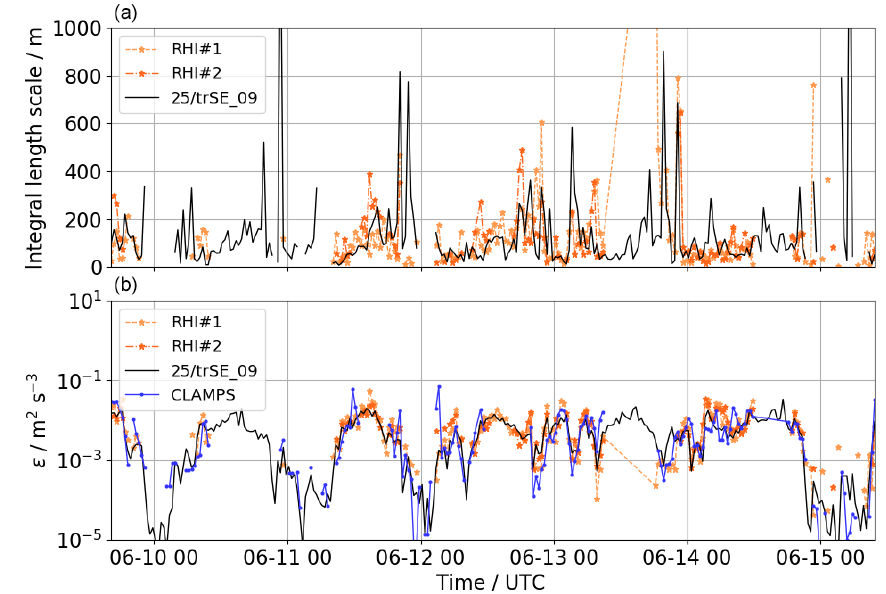
Figure 6. Comparison of time series of L v (a) and ε (b) for the period form 9 to 15 June 2017 for the two RHI lidars RHI#1 and RHI#2 and the sonic anemometer at 100m on tower 25/trSE_09 in the valley. Estimates for the sonic anemometer are calculated for horizontal wind speed.